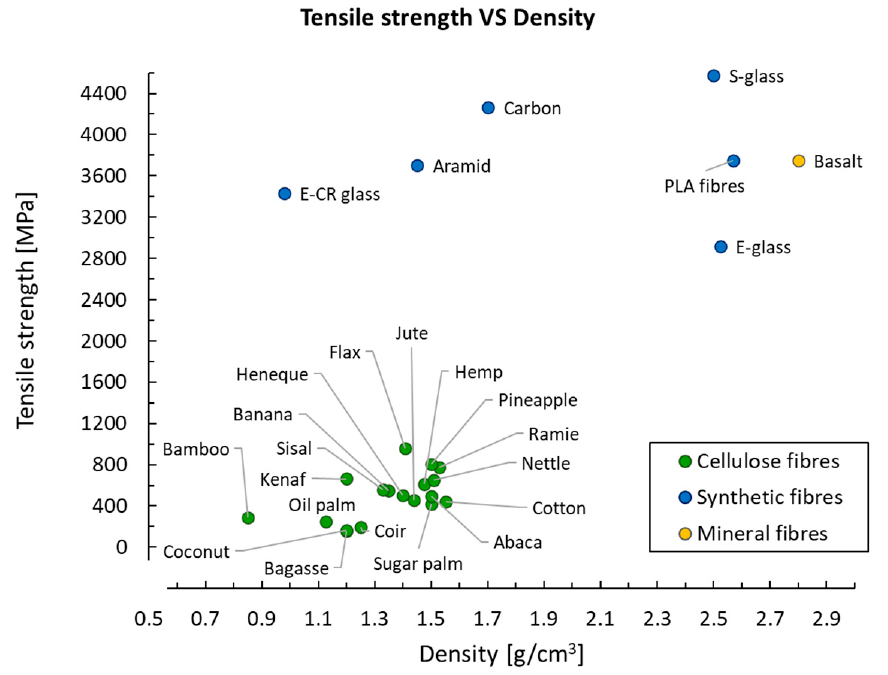
Figure 6. Map of the tensile strength against density for several cellulose, synthetic, and mineral fibres. Data from [52, 55, 58-63].